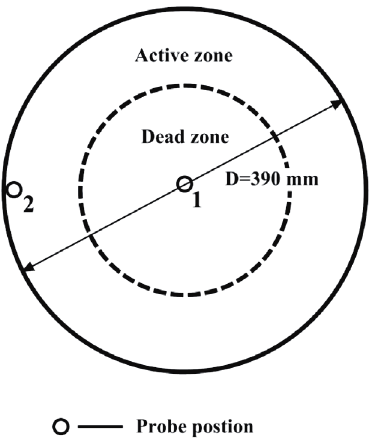
Fig. 4: Typical example of definition of mixing